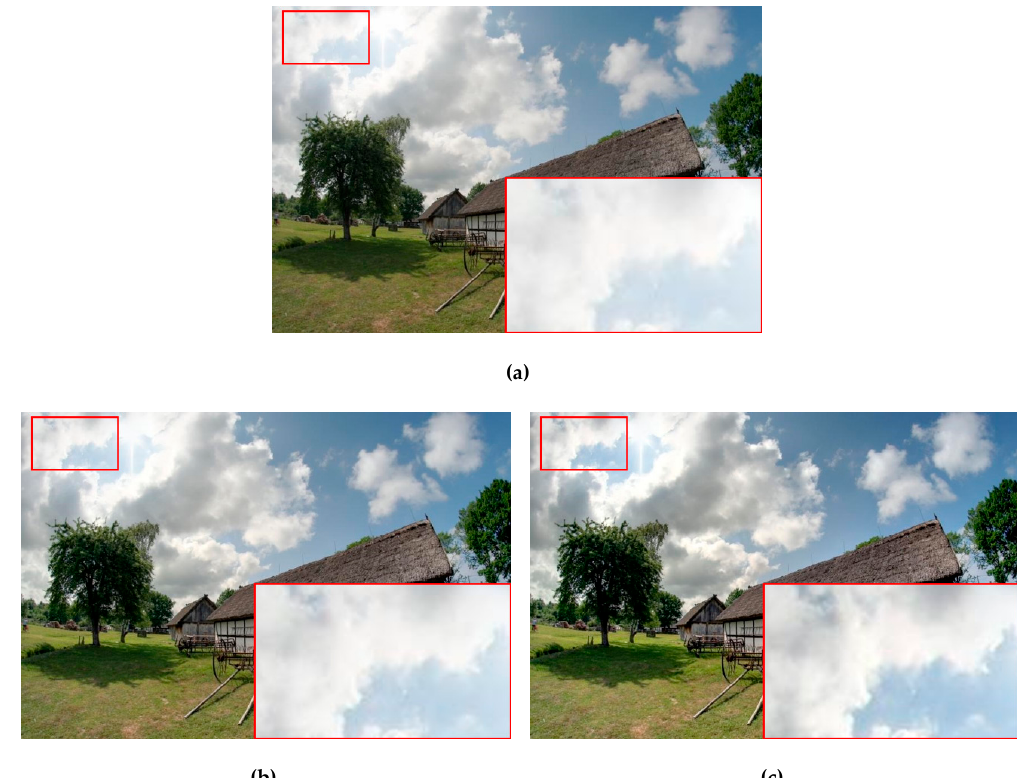
Figure 3. Visual comparison of the exposure fusion results from different weighting processes. ( a ) Well-exposedness only; ( b ) both the well-exposedness and local pixel-visibility using fuzzy logic; ( c ) the inter- and intra-image information using the proposed fuzzy-MNCRF model. For this example, the three input differently exposed images are shown in Figure 4.